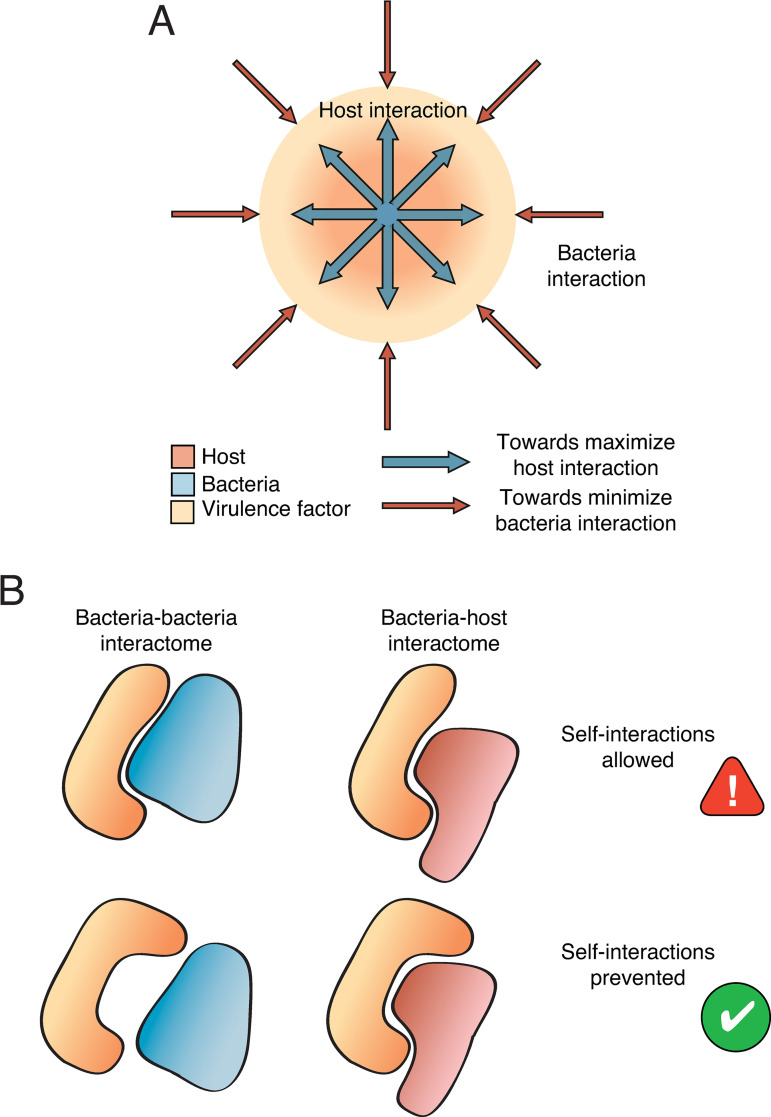
Organization restraints for host-pathogen interactions.(A) Effectors involved in host-pathogen interactions must optimize the interaction with host proteins while keeping undesired interactions under control within the pathogen interactome. (B) This balance is achieved through structural imperfect mimicry. Proteins retain the core interface to strongly interact with the host but modulate its geometry and the rim areas to minimize potentially detrimental self-interactions.